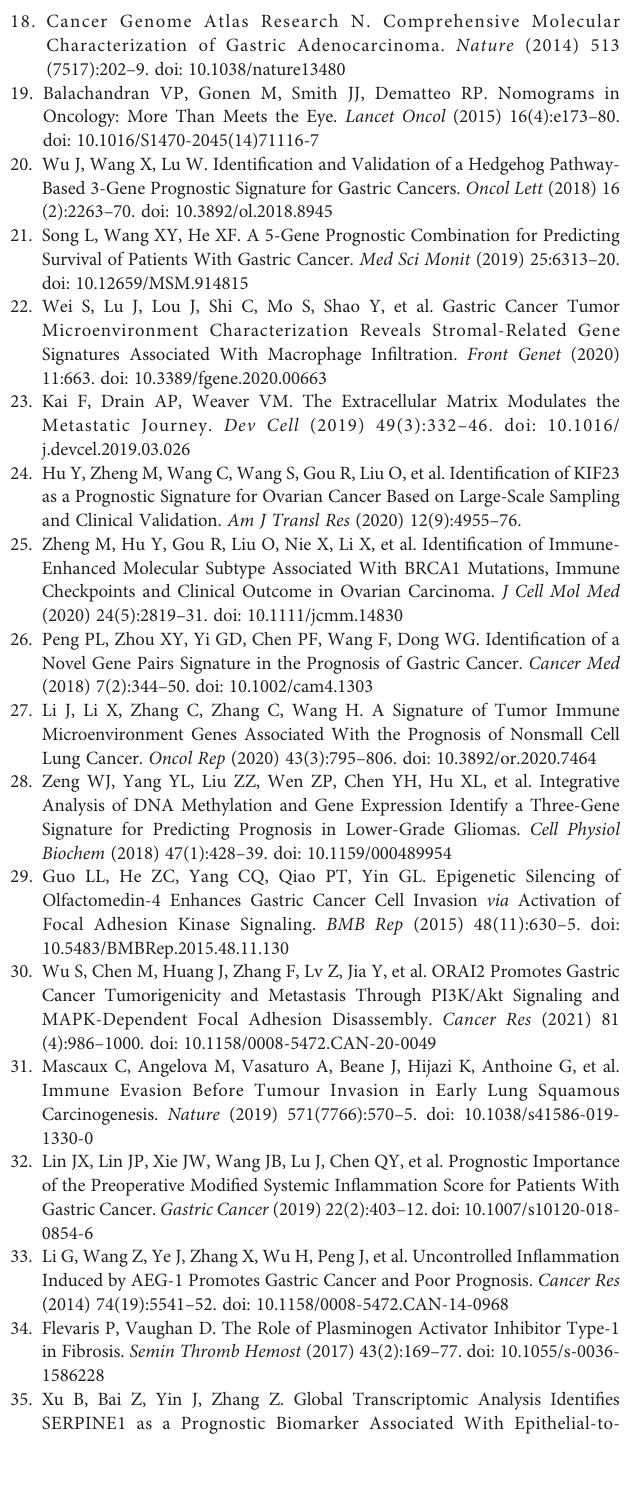
Supplementary Figure 1 | Comparison of the expression offour genes between tumour and healthy samples included in TCGA dataset.